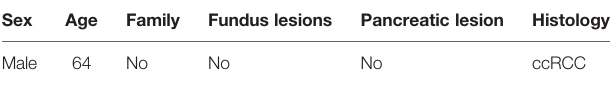
TABLE 1 | The information of